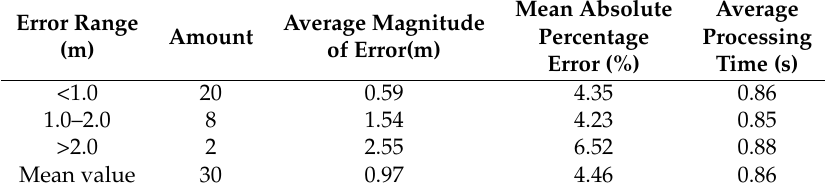
Table 1. Analysis of the prediction results of the jet trajectory range.